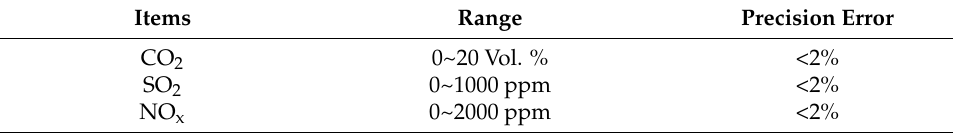
Figure 1. Route map of the ship during the whole sampling time. Table 1. The parameters of the real-time monitoring